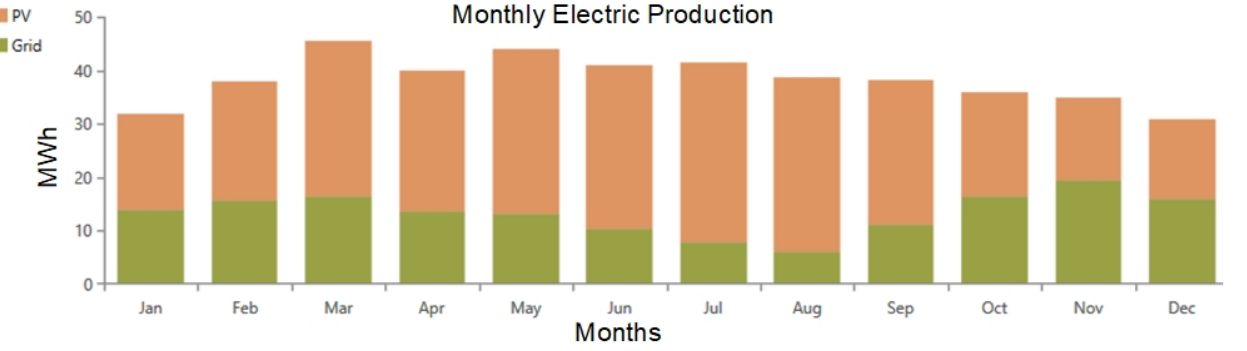
Figure 11. Monthly distribution of taken and delivered energy according to network. Via a sensitivity analysis, 42,280 solutions were simulated, all of which are feasible only with different NPCs. The sensitivity analysis in relation to the price of energy delivery to the network (Figure 12) showed that the share of renewable energy sources increases only above the price of EUR 0.05/kWh and that the share of renewable energy sources in the network is over 50% at a price of EUR 0.096/kWh.